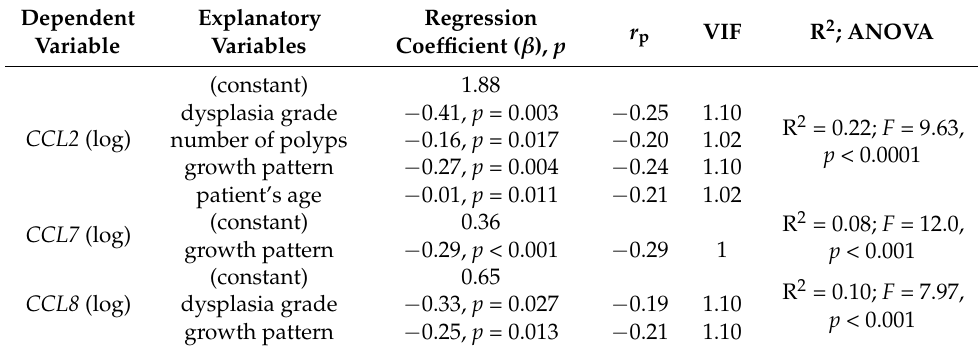
Table 5. Regression models explaining expression of MCP chemokines in colorectal adenomas.